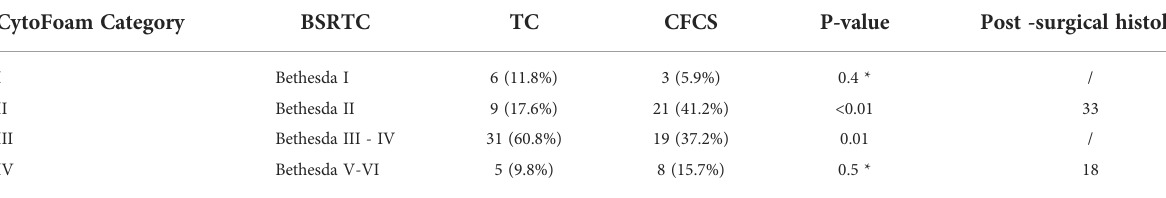
TABLE 3 Comparison of the results of CytoFoam categories vs the traditional cytology classes.